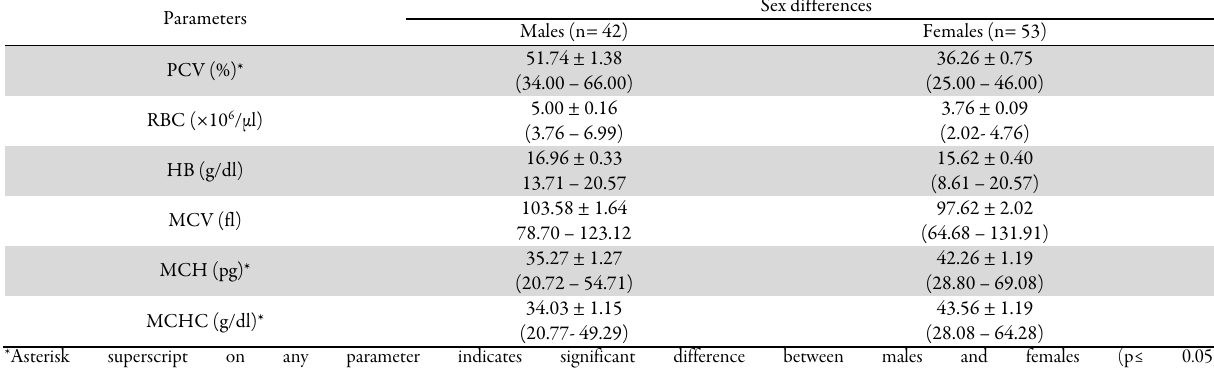
Table 3. Comparison of the erythrocytic profile of the male and female adult Japanese quail ( Coturnix coturnix japonica ) Parameters